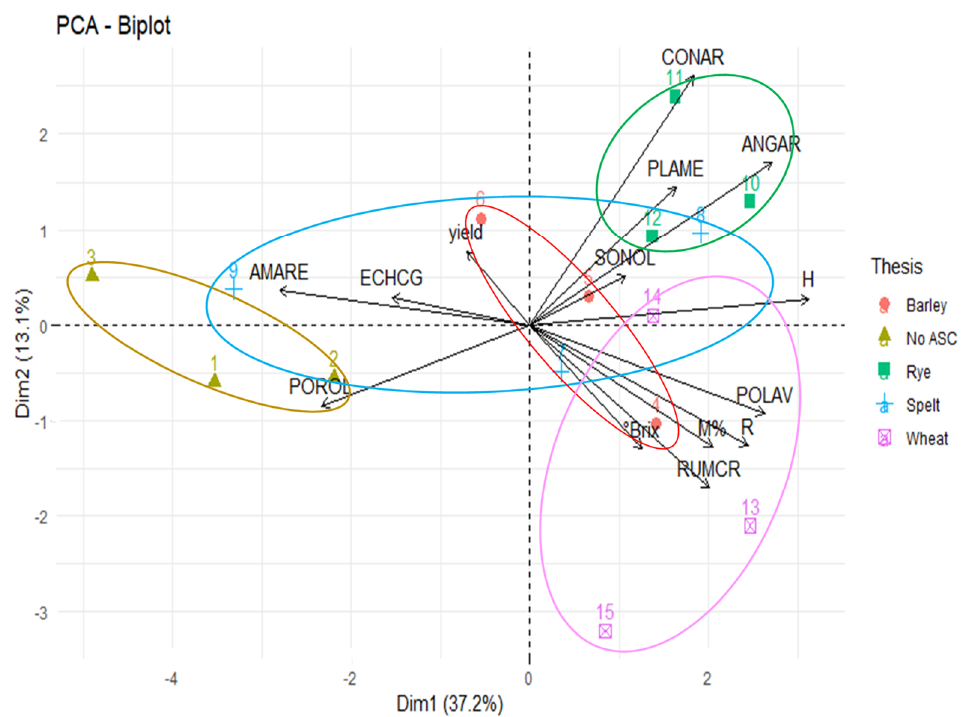
Figure 4. Principal components analysis (PCA) biplot and confidence ellipses ordering the organic melon experimental trial relative to main weed species cover (%), frequency (%) of Polygonum aviculare (POLAV), Anagallis arvensis (ANGAR), Rumex crispus (RUMCR), Convolvulus arvensis (CONAR), Plantago media (PLAME) and Sonchus oleraceus (SONOL), Shannon–Weaver index (H), species Richness (R), melon root mycorrhizal colonization intensity (M%), melon yield and Brix at the August sampling time. Note: No_ASC,